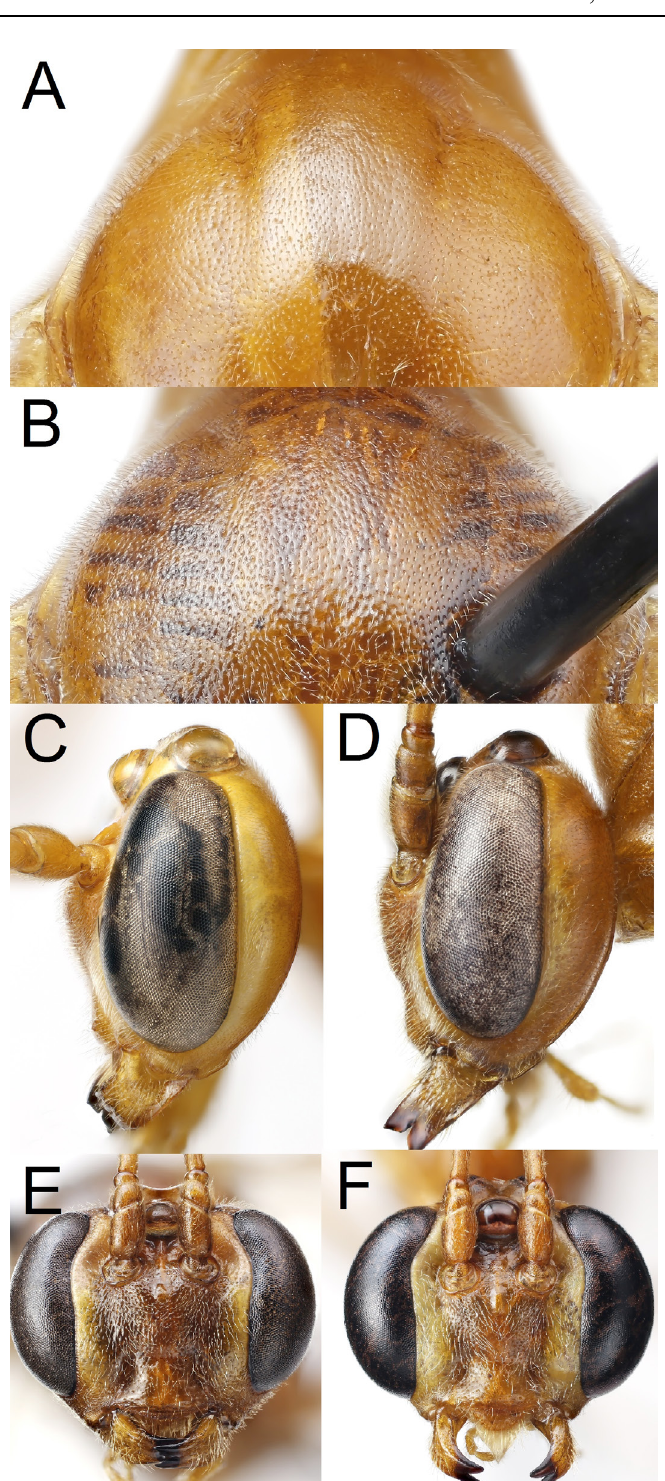
Fig. 21. A–B . Mesoscutum, anterior part of female, dorsal view. A . Ophion ellenae Johansson sp. nov., paratype, ♀ (MZLU 6370:1). B . O. matti Johansson sp. nov., paratype, ♀